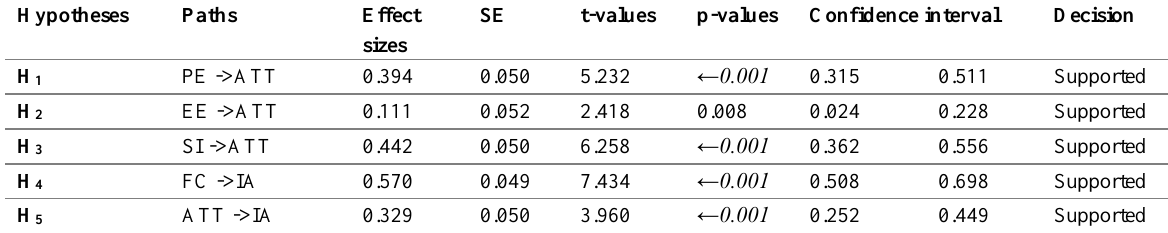
Table 5: Assessing the Structural